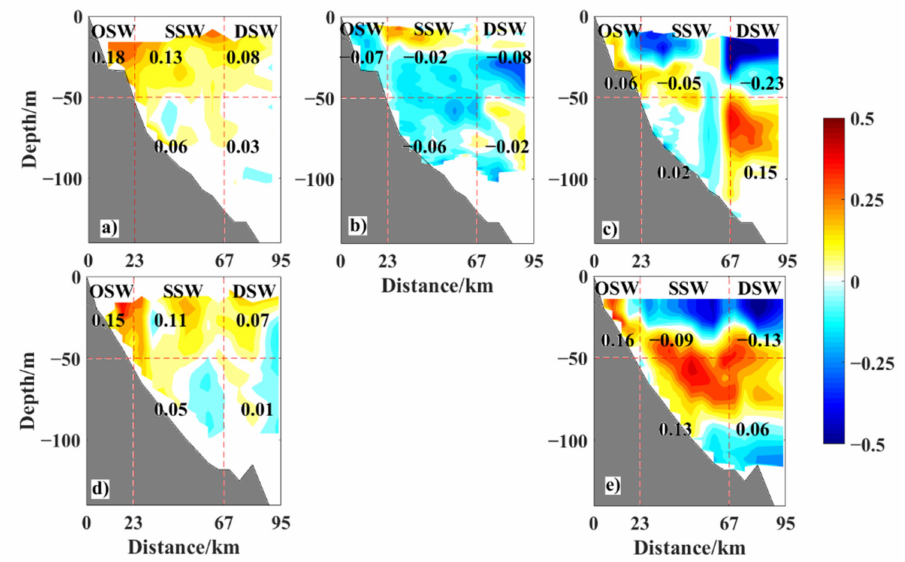
Figure 5. Two-dimensional (2D, x – z ) distribution of the along-shore velocity component v a (m/s) in section H ( a ) and F ( d ) without the typhoon, section H ( b ) before the typhoon, and sections H ( c ) and F ( e ) after the typhoon. Red dotted lines represent the positions of the 50 m isobath, the 120 m isobath, and a depth of 50 m. Numbers represent the average velocities in the portions of waters.